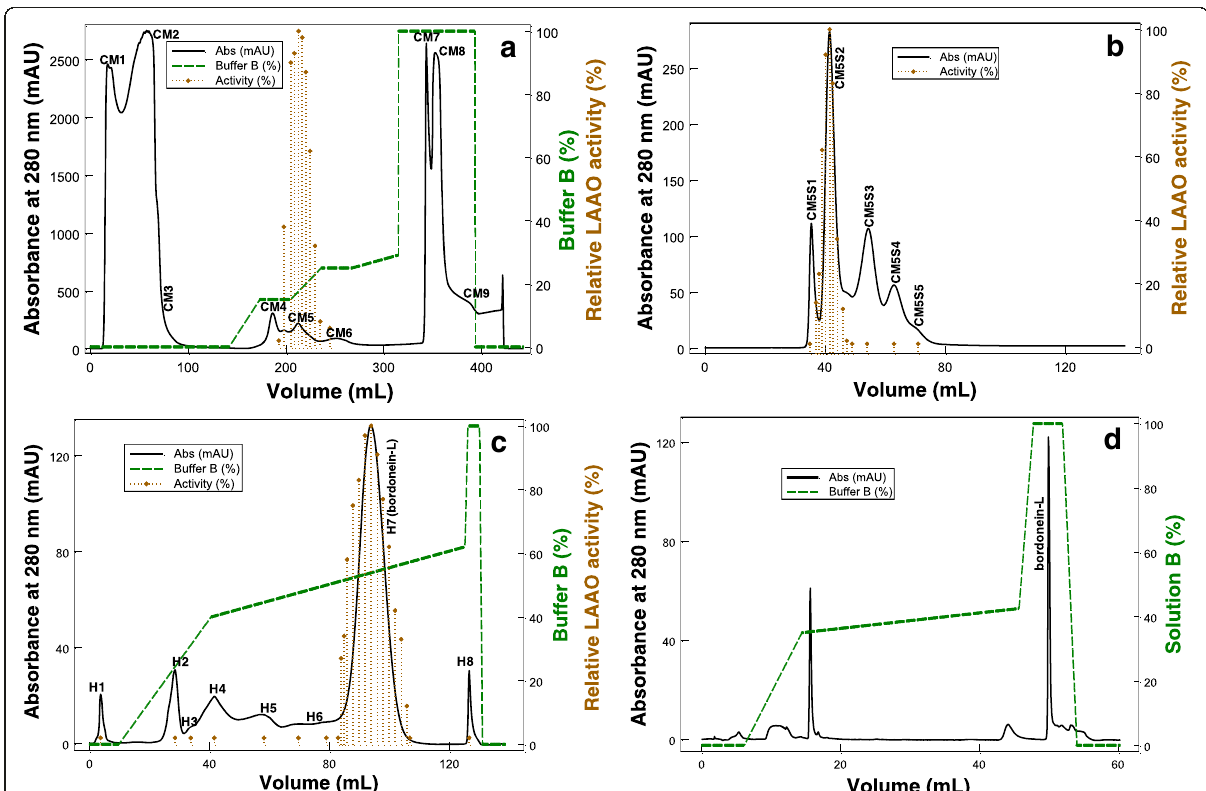
Fig. 1 Isolation of Bordonein-L. Absorbance was monitored at 280 nm, at 25 °C, using a FPLC Äkta Purifier UPC-10 system. The dotted lines represent the concentration gradient. The vertical bars indicate the LAAO activity. a CdtV (1 g) was dispersed in 50 mL of 0.05 M sodium acetate buffer, pH 5.5 (buffer A) and the supernatant was fractionated on a CM-cellulose-52 column (1.0 × 40 cm) using a concentration gradient from 0 to 100 % of buffer B (1 M NaCl in buffer A). b The fraction CM5 was filtered on a HiPrep 16/60 Sephacryl S-100 HR column (1.6 × 60 cm) using 0.05 M sodium acetate buffer containing 0.15 M NaCl, pH 5.5. c Affinity chromatography of the CM5S2 fraction on HiTrap Heparin HP column (two 1-mL columns connected in series) using a concentration gradient from 0 to 100 % of buffer B. d Reversed-phase FPLC of H7 (bordonein-L) on a C4 column (0.46 × 25 cm, 5 μ m particles) using a concentration gradient from 0 to 100 % of solution B (60 % acetonitrile in 0.1 % TFA)